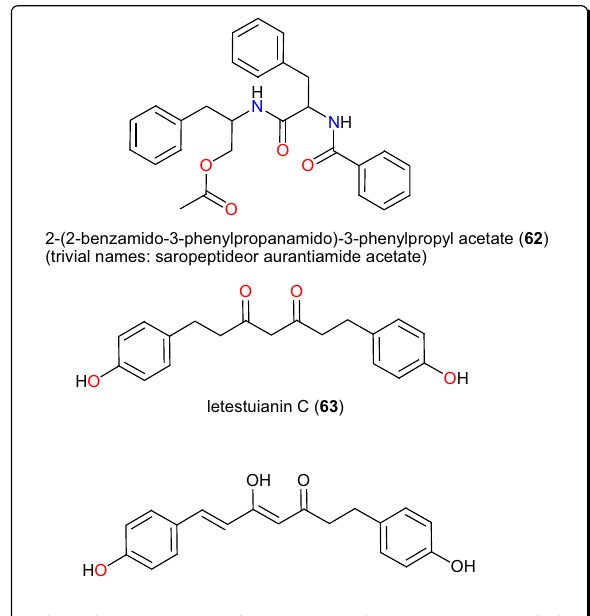
Fig. 11 An antitrypansomal amide and two